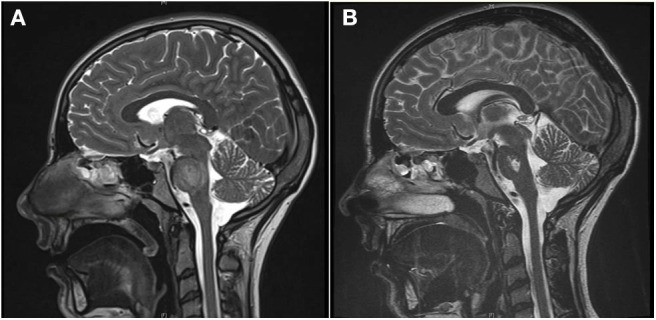
(A) The T2-weighted magnetic resonance tomography shows a diffuse increase of signal intensity and edema in the pons during the acute phase of central pontine myelinolysis. (B) Four weeks later, the edema has resolved, but a trident-like substance defect in the pons remains (T2 weighting).